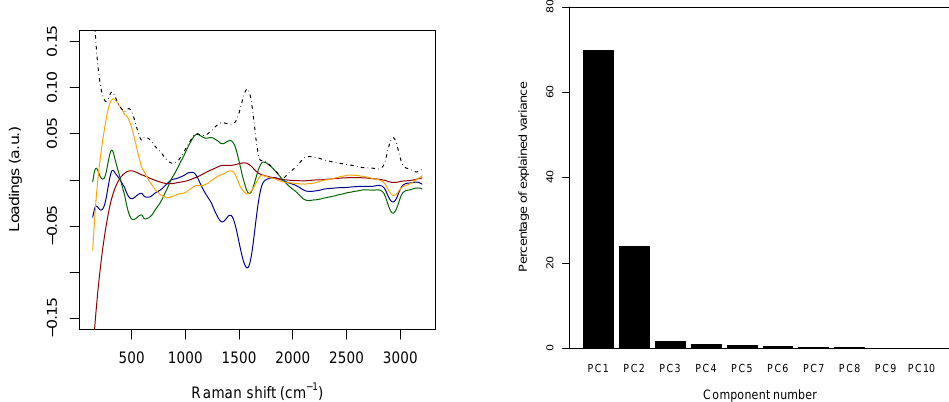
Figure 5. ( Left ) the four solid lines report the loadings associated with the first four principal components (blue first, brown second, green third, and yellow fourth); the dashed black lines are the intensity, i.e., the square root of the sum of the squares, of the loadings of the first four components. ( Right ) percentage of variance as a function of the principal component index.